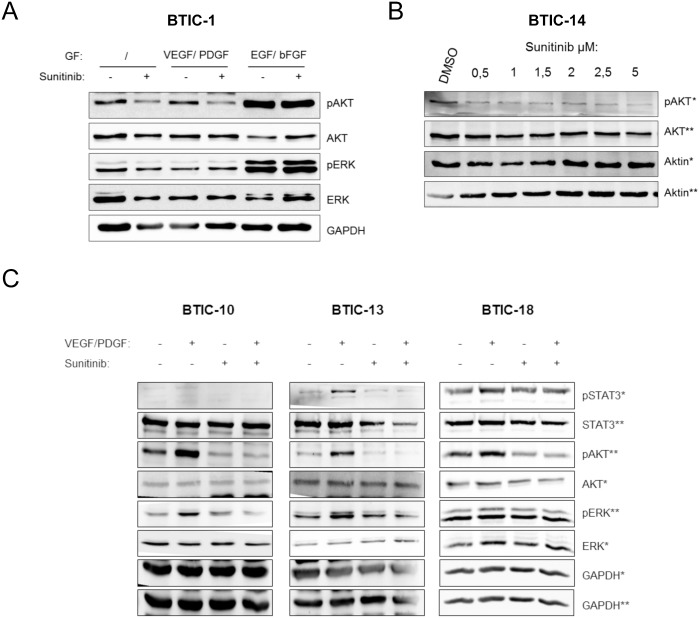
Phosphorylation pattern of signaling molecules downstream of Sunitinib target receptor tyrosine kinases.Western Blot analysis was performed with 18 BTIC lines of which 3 representatives are shown. (A) To evaluate distinct phosphorylation patterns under treatment, BTIC-1 was treated with 1 µM Sunitinib or 0.00025% DMSO for 6 hours with growth factor supplementation (25 ng/ml) as outlined. (B) To evaluate a dose curve for Sunitinib, BTIC-14 cells were incubated with different Sunitinib-concentrations or 0.001% DMSO in media supplemented with 25 ng/ml of each VEGFA and PDGF-AB. (C) After definition of growth factor supplementation and Sunitinib dose, Western Blot analysis for changes in phosphorylation after treatment with Sunitinib was performed with 18 BTIC lines of which 3 representatives are shown. Cells were treated with 1 µM Sunitinib or 0.00025% DMSO with (+) or without (–) growth factors (GF) PDGF-AB and VEGFA (25 ng/ml) for 6 h after incubation in growth factor free medium for 16 h. The asterisks (*) indicates the corresponding loading control. GAPDH was used as protein loading control.